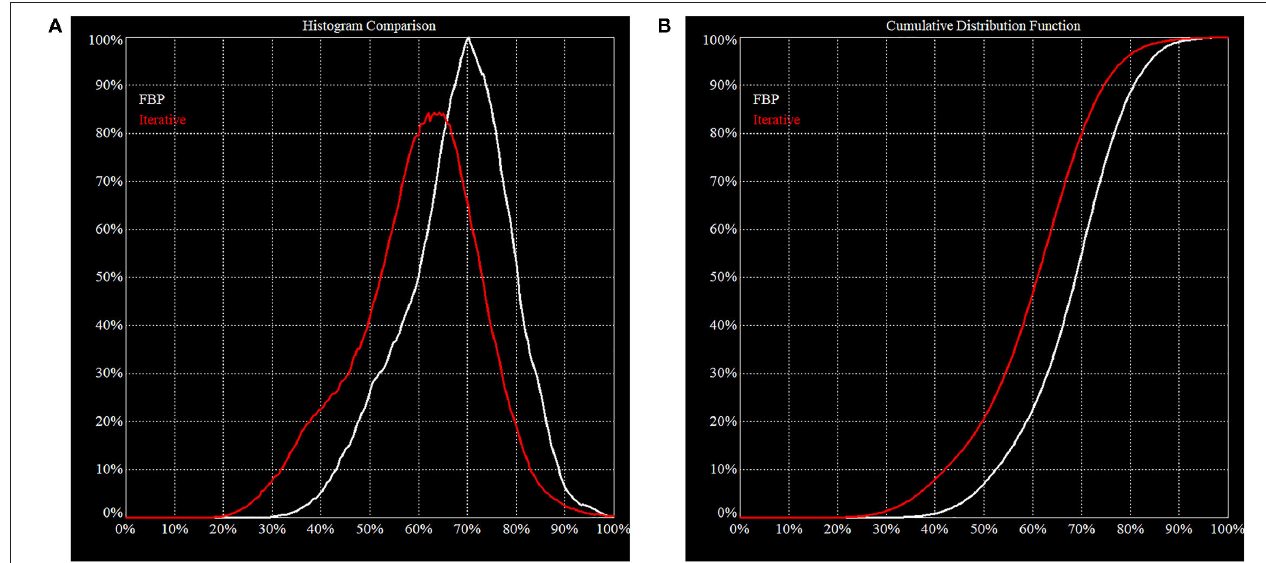
FIGURE 4 | Histogram of FBP (white line) vs. Iterative Reconstruction (red line). These figures illustrate the difference in behavior of FBP vs. IR on the same clinical projection data. (A) The area under the histogram curves is the same but the peak is shifted downwards for IR. This is consistent with our expectation that IR will increase image contrast, i.e., the noise is pushed down, and a higher maximum is resolved. (B) In a cumulative distribution curve, the median count of the reconstructed volume is lower which must be considered when making direct comparisons.